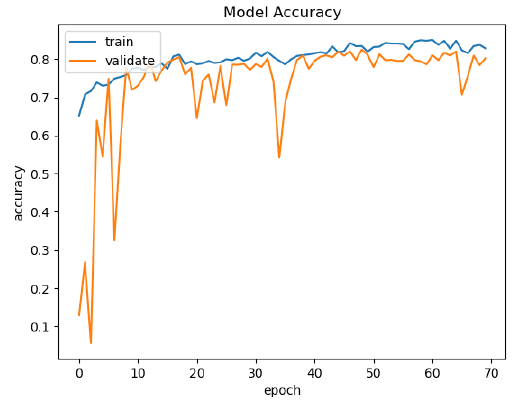
Figure 17. ResNet-SegNet Acc.